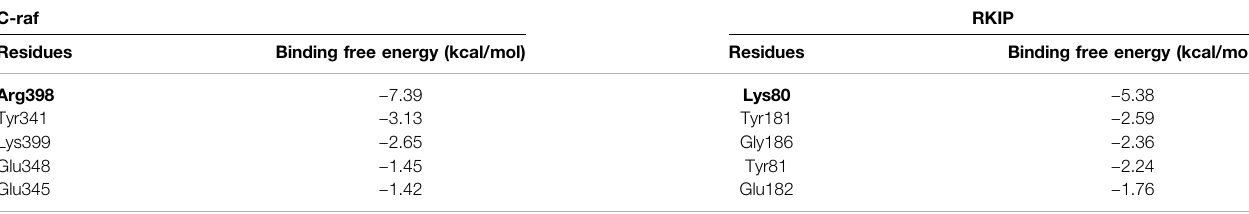
*Majorly contributing residues highlighted in bold.